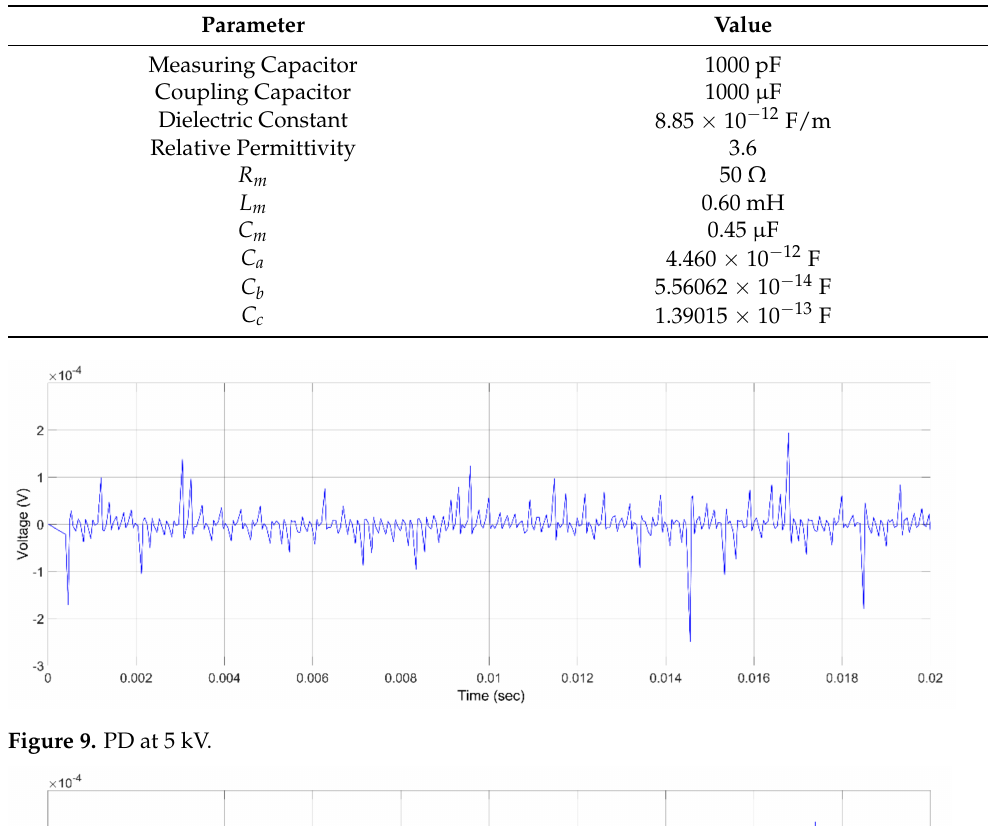
Table 1. Simulation Parameters (Epoxy Resin).